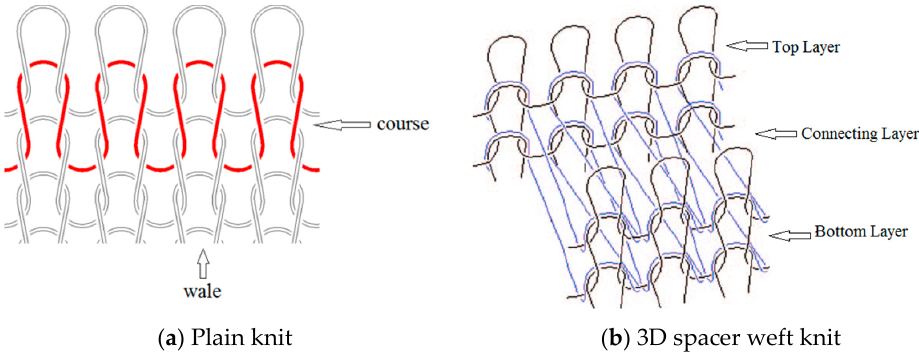
Figure 7. Knitted fabric structure.